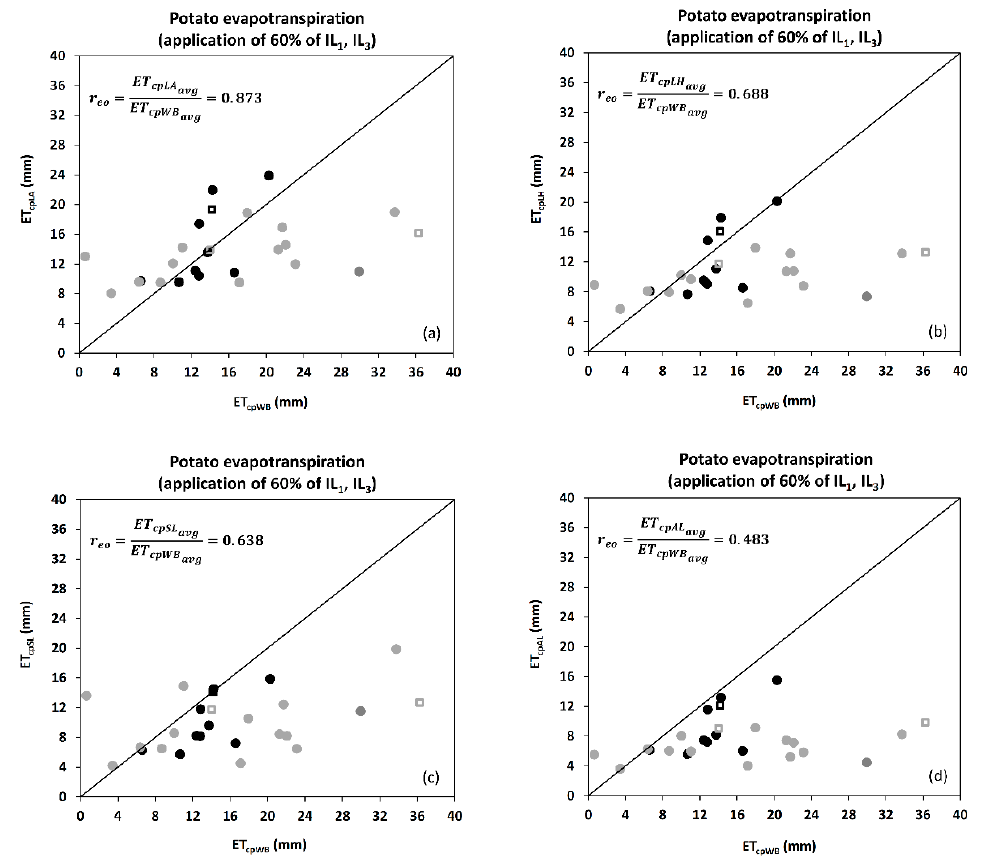
Figure 8. Comparison between potato evapotranspiration estimated by the water balance ( ET cpWP ) and Penman-Monteith ( ET cp ) methods using four canopy resistances approaches for the application of 60% of IL 1 (IL 3 ) in both seasons. LA and LH [63], SL [62] and AL [28] corresponding to the canopy resistance ( r c ) model at each ET cp approaches used in this study. ( a – d ) represent to LA, LH, SL, and AL, rspectively. Closed circles and open squares of black color correspond to the 2018/2019 season, whereas closed circles and open squares of gray color correspond to the 2019/2020 season. Square and circle points represent values of ET when LAI < 2 and LAI > 2, respectively. Each point compares the sum of ET among consecutive irrigation events.